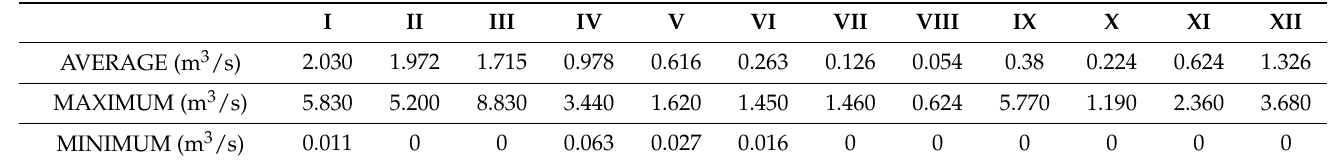
Table 1. Minimum, maximum, and average flow rate at the Miljaši´c Jaruga water gauge station for the period 1996 to 2018